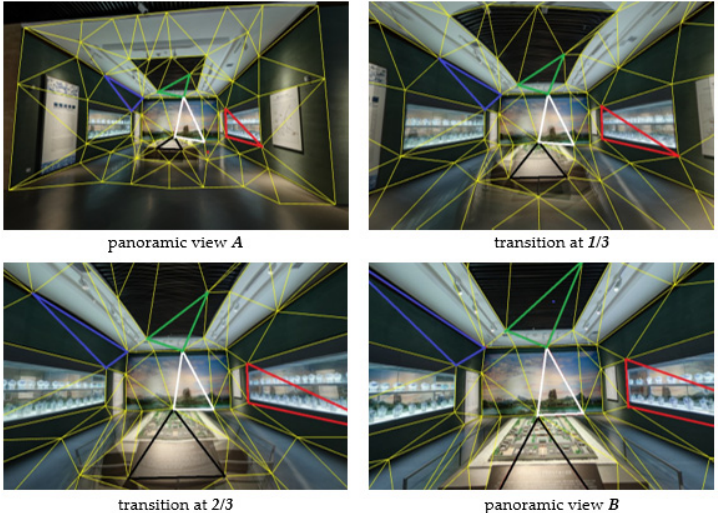
Figure 1. Principle schematic diagram of panorama transition guided by matched triangular patches.